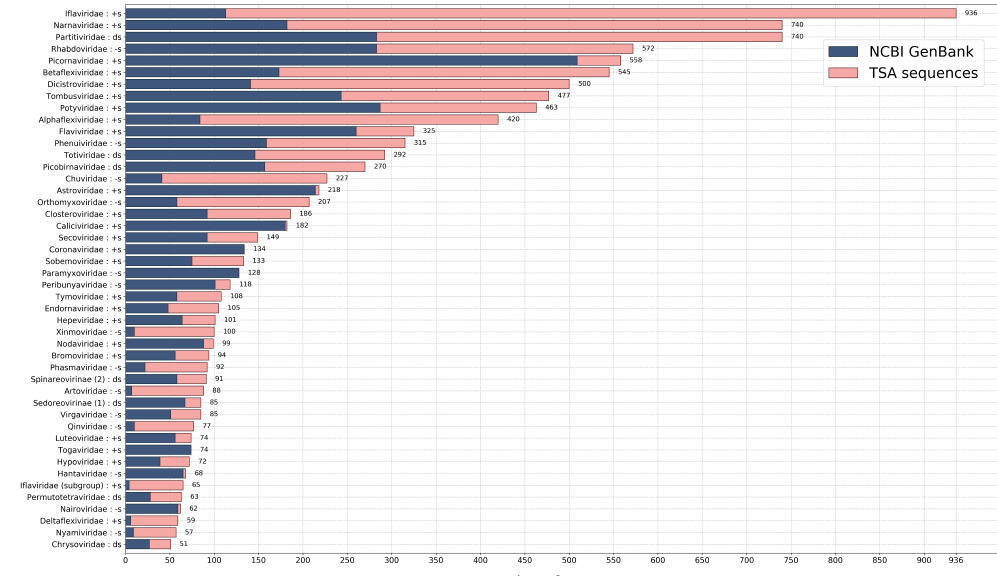
Figure 1. The number of identified non-identical RdRp sequences. Each identified sequence with high score was trimmed to the RdRp core and then sorted into the genetically most similar group (the best HMM profile match). The 100% identical sequences within a group have been removed. Here, we only show groups, where the total number of sequences left are above 50. The genome type of each group is identified as follows: +s is positive single-stranded, -s is negative single-stranded and ds is double-stranded RNA genome. The source of the sequences is identified by different